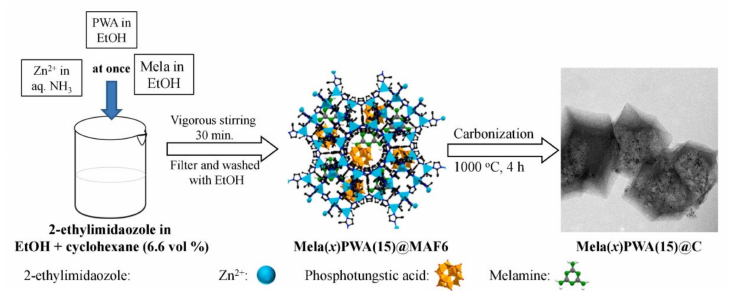
Figure 8. Preparation process of Mela(x)PWA(15)@C material (reproduced from Ref. [123], copyright 2021